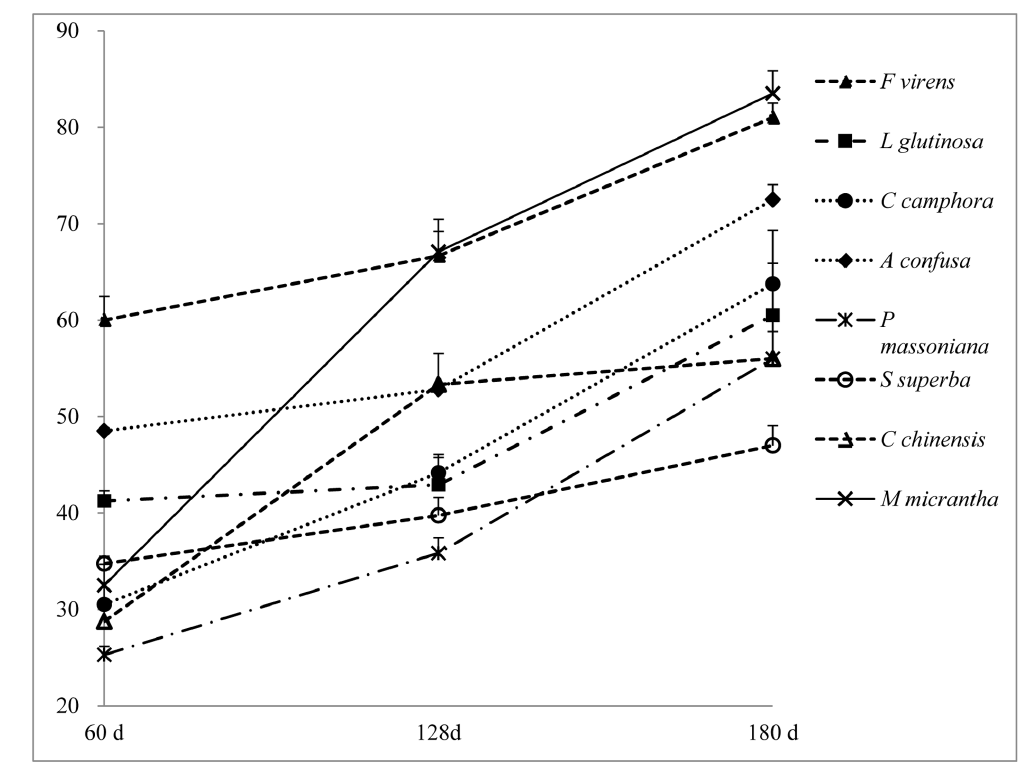
Figure 1. Mean ( + SE, n=4) percentage of litter mass loss of the 7 native single species and non-native (exotic) invasive species M. micrantha after 60 d, 128 d and 180 d decay. The analysis of litter mass loss among 8 single species over each decay time by ANOVA is shown in Table S1.